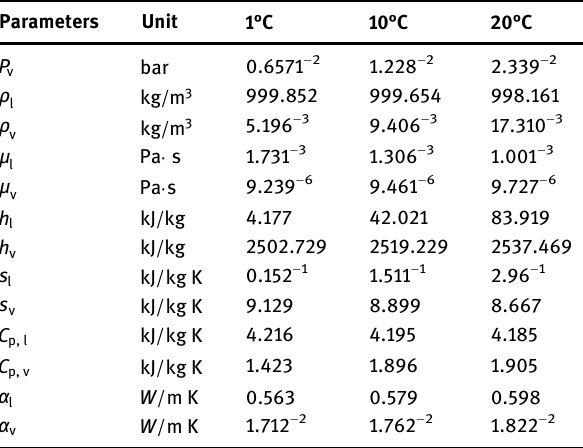
Table 3: A summary of the parameters in di ff erent temperatures